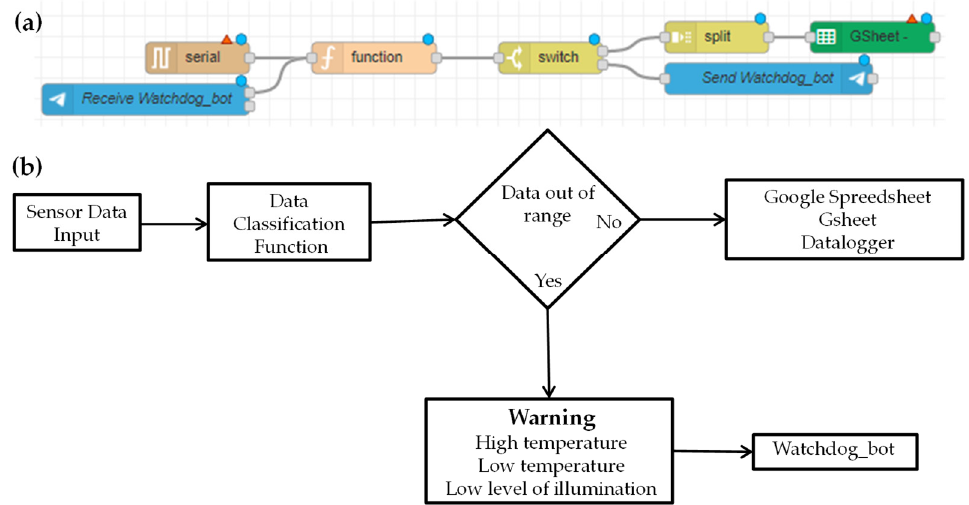
Figure 4. ( a ) System flow in node-RED. ( b ) System flow diagram.